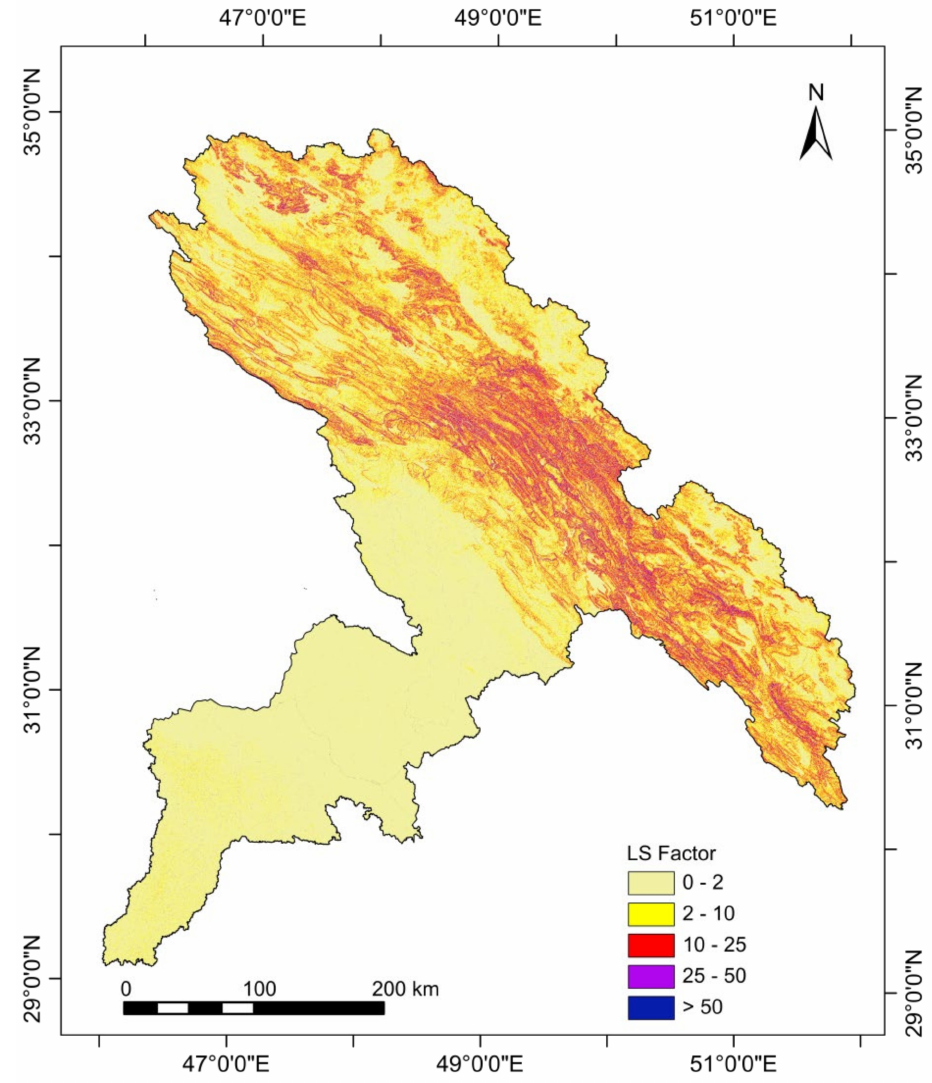
Figure 5. Spatial distribution of LS factor in the study